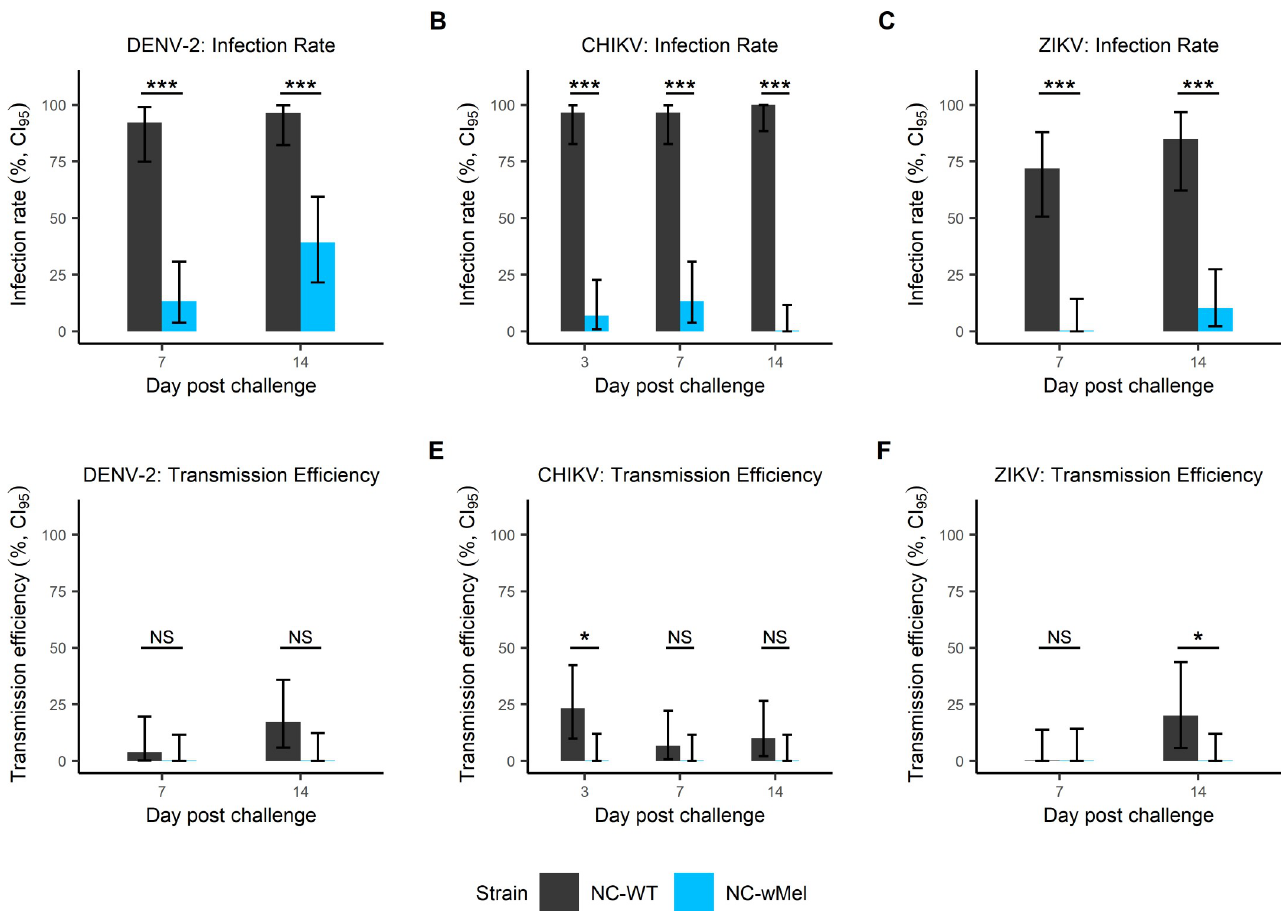
Fig 1. Infection rates and transmission efficiencies for NC-WT and NC- w Mel Aedes aegypti strains orally challenged with DENV-2, CHIKV or ZIKV. (A, B, C) Infection rates and (D, E, F) transmission efficiencies obtained for DENV-2, CHIKV, and ZIKV respectively at different days post-challenge. Errors bars indicate Confidence Interval at 95%. Statistically significant differences are shown in the figures (Fisher’s exact test; � : p -value < 0.05; �� : p -value < 0.01; ��� : p -value < 0.001; NS: not significant).